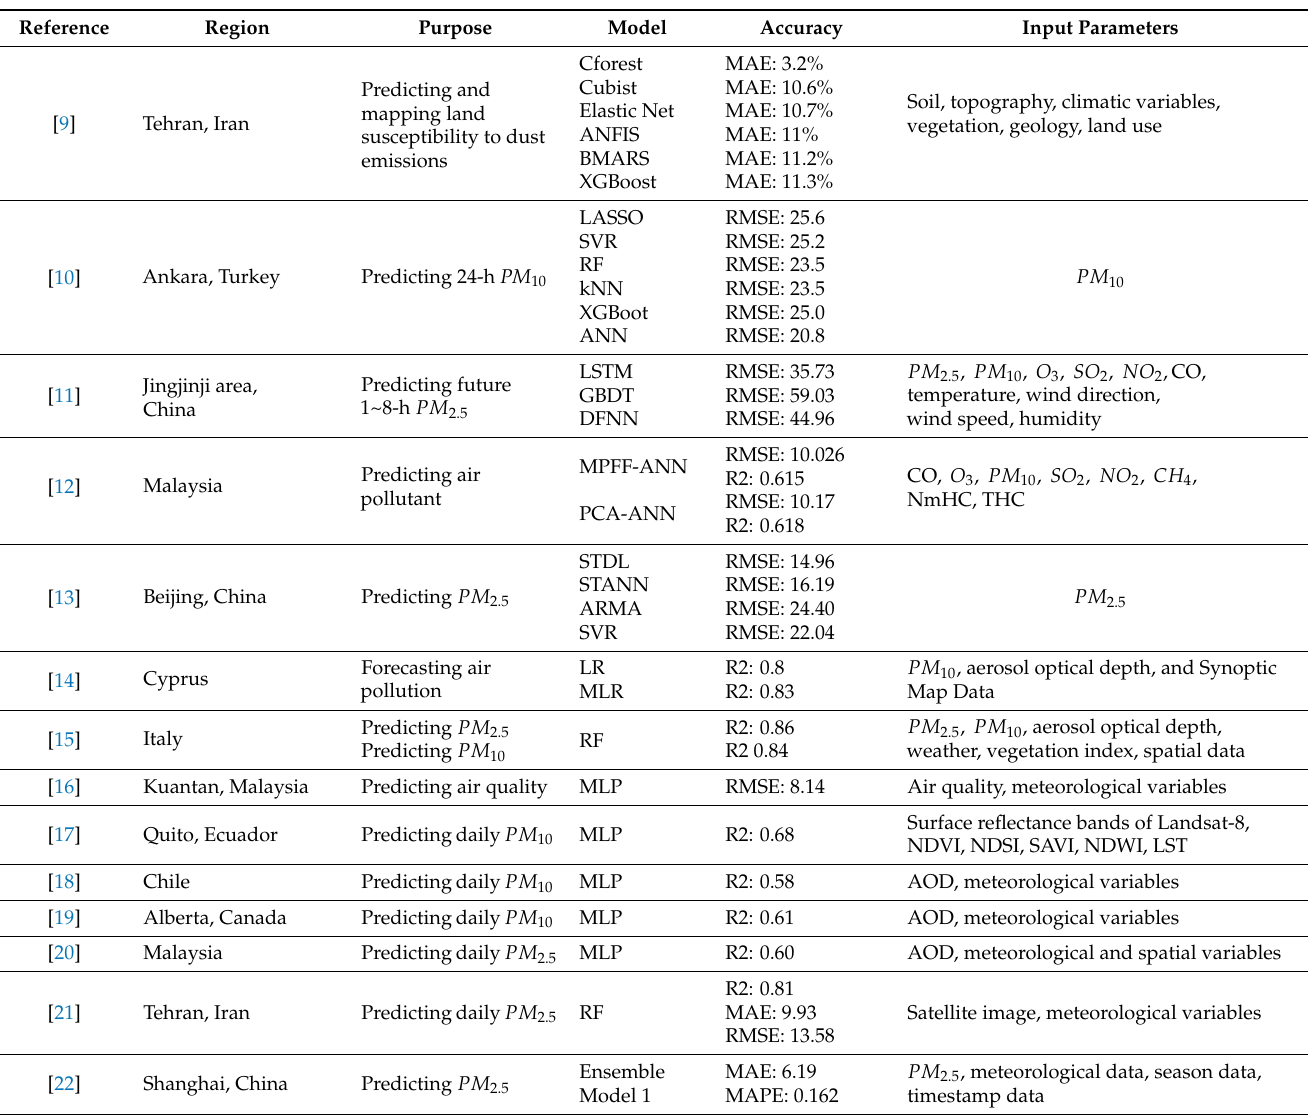
Table 1. Machine learning (ML) and deep learning (DL) models for air quality and dust (created by